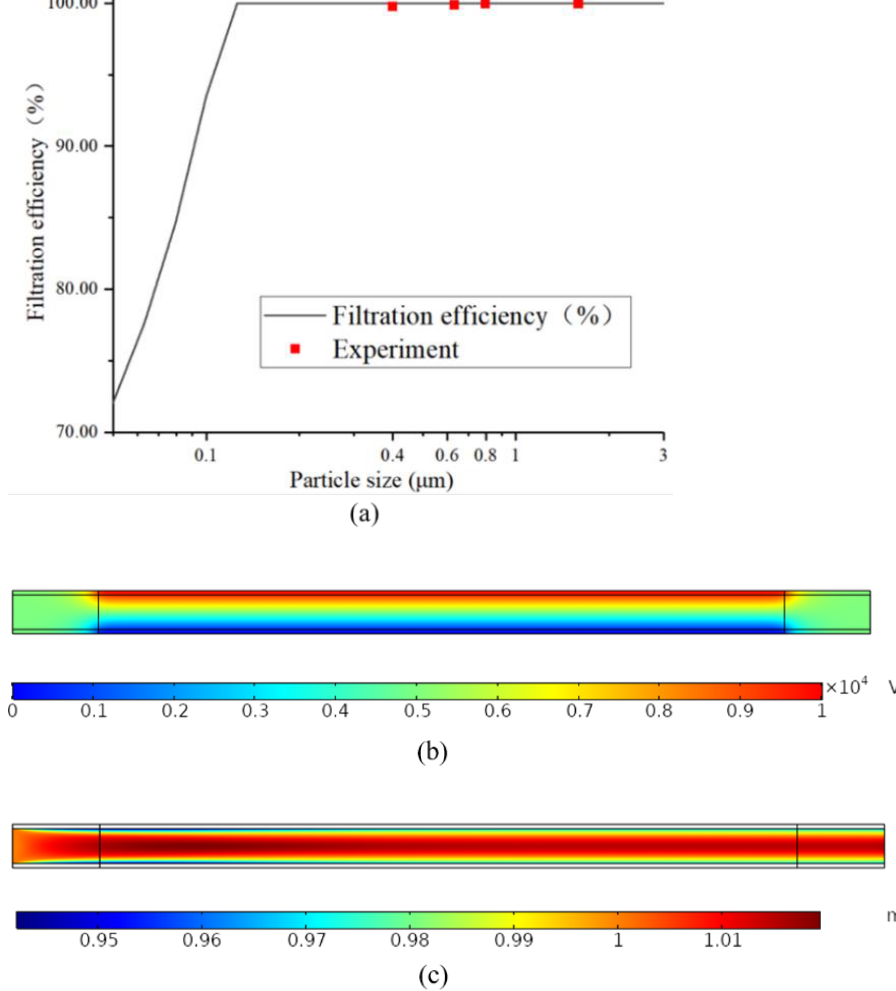
Figure 5. Model verification results: ( a ) fractional efficiency by particle size; ( b ) electric field simulation results of single channel; ( c ) velocity field simulation results of single channel.